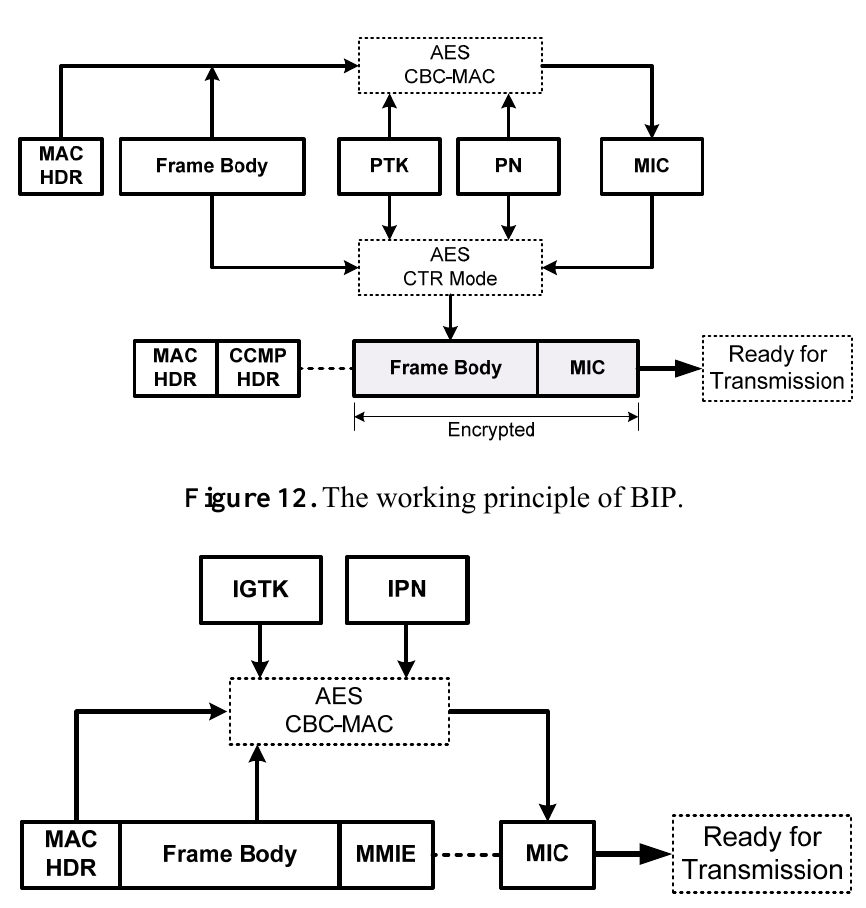
Figure 11. The working principle of CCMP.